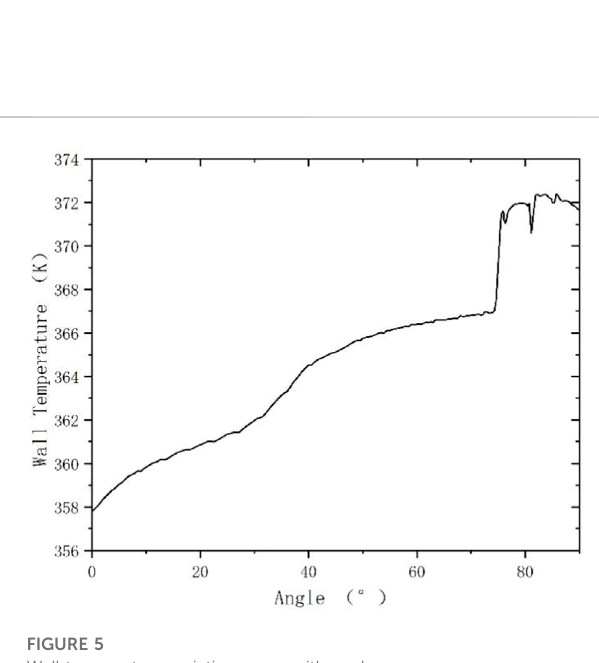
Wall temperature variation curve with